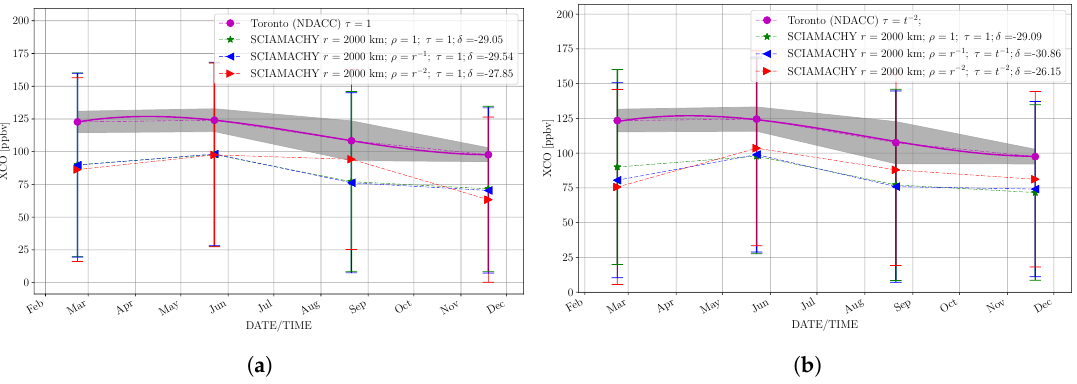
Figure 11. The 90-day averages within 2000 km from the Toronto truthing site in 2003. In ( a ) only spatial weighting was applied in the calculation of averages while in ( b ) both spatial and temporal weighting was used. δ designates the offset of the averages between xCO from SCIAMACHY and